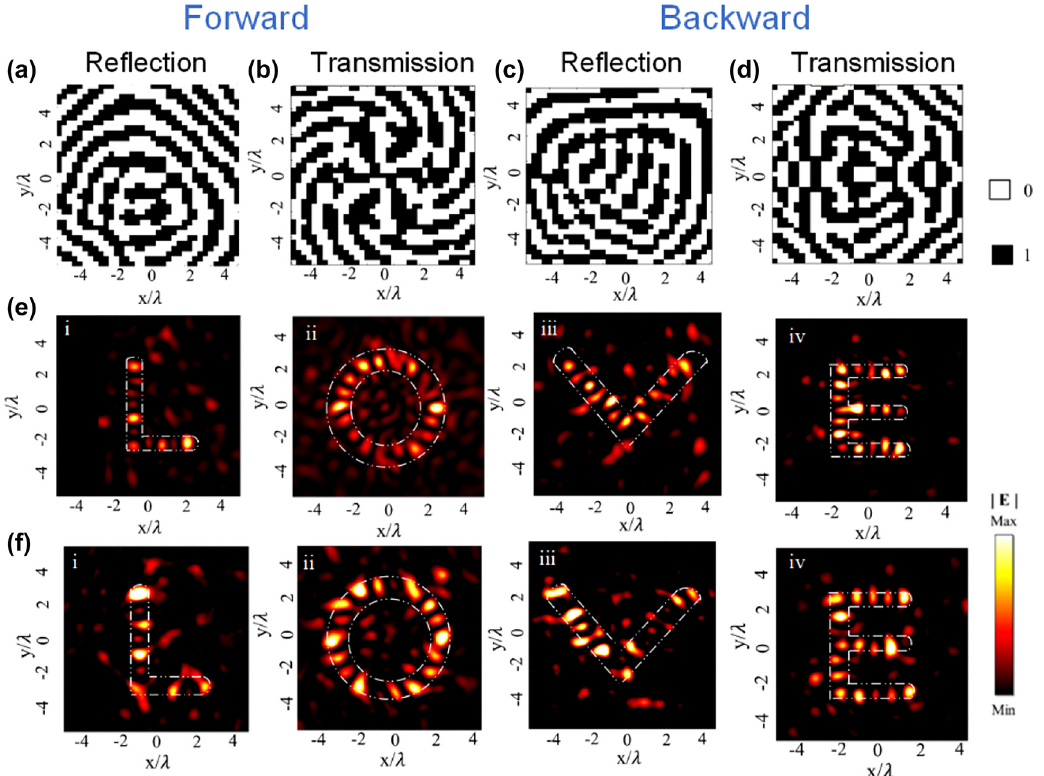
Figure 5: Characterization for the reflection-transmission-integrated multichannel holographic metasurface. (a) and (b) Phase distribution of the co-polarized reflected image ‘‘L’’ and cross-polarized transmitted image ‘‘O’’ with the linearly polarized forward incident wave. (c) and (d) Phase distribution of the co-polarized reflected image ‘‘V’’ and cross-polarized transmitted image ‘‘E’’ with linearly polarized backward incident wave. (e) Electric field distribution of corresponding simulation results in each channel. (f) Electric field distributions of corresponding experimental results in each